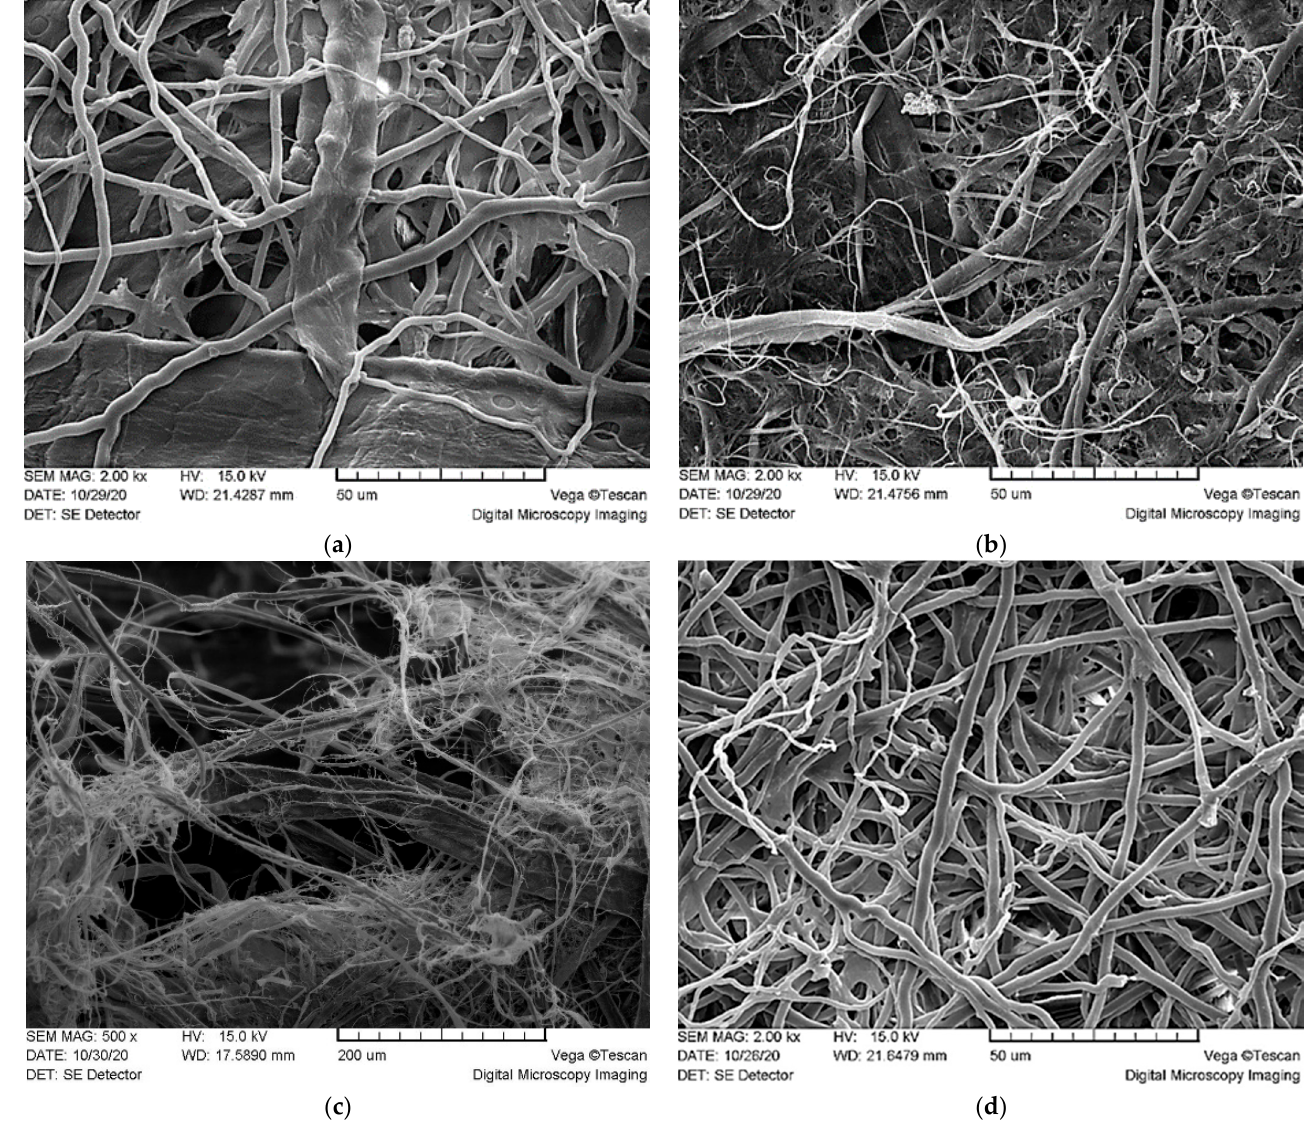
Figure 2. Ultrastructure (SEM, magnifications are given after sample name) of the materials: ( a ) KF FF, 1000×; ( b ) HF FF, 2000×; ( c ) HF KF FF, 500×; ( d ) FF, 2000×.